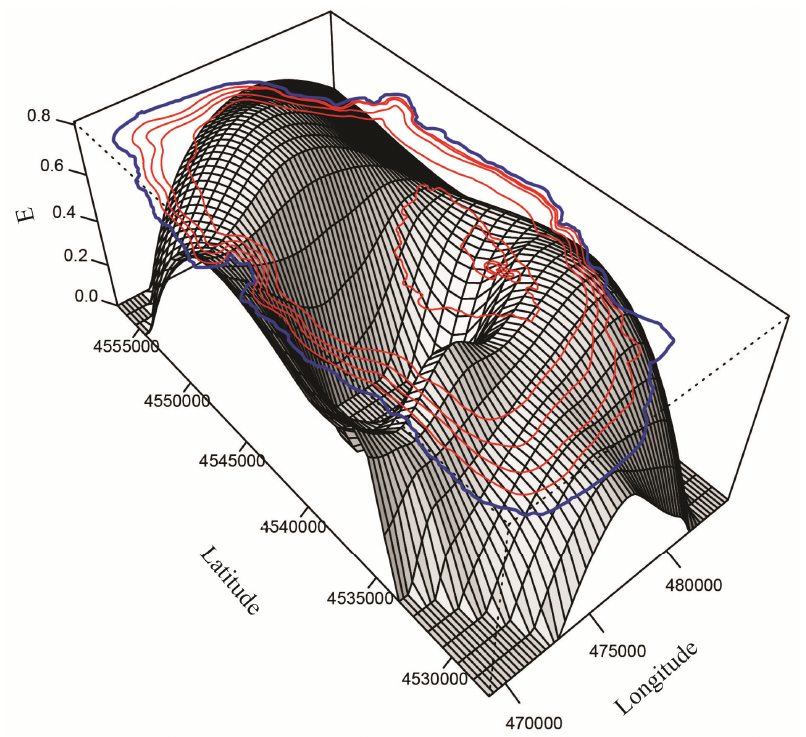
Figure 11. Spatially modeled species evenness (E) in Lake